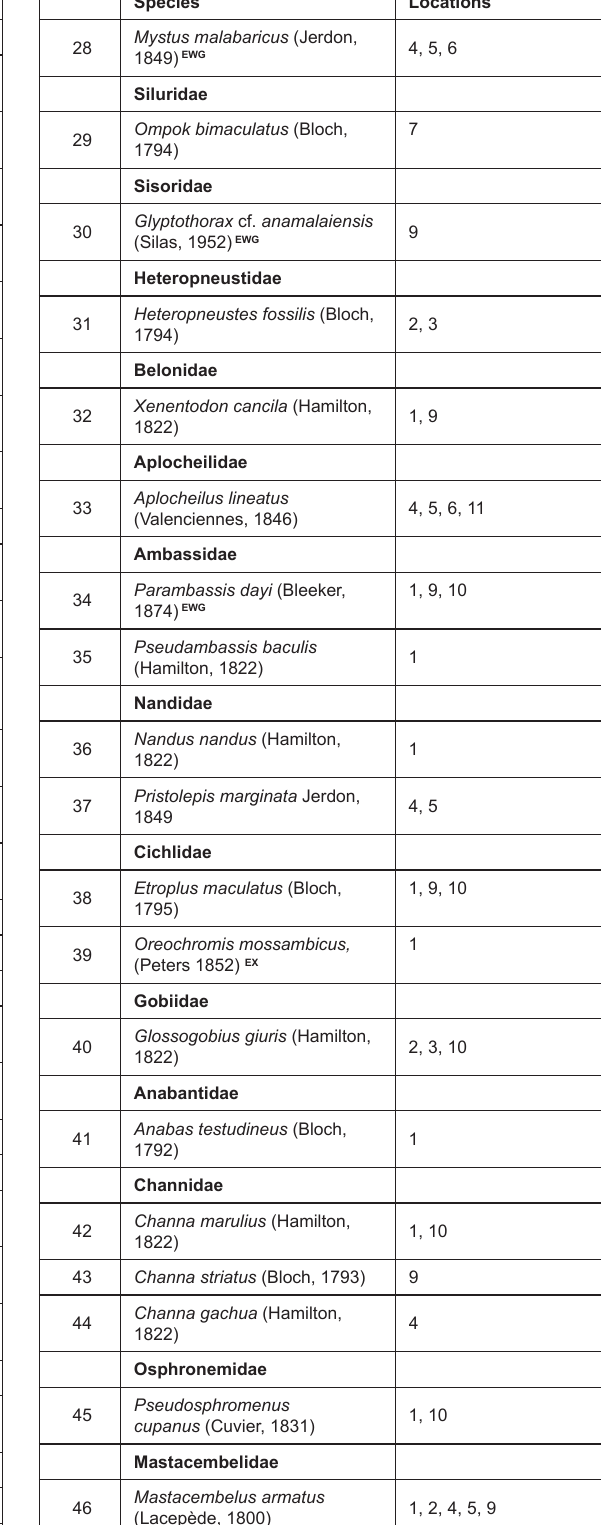
Table 2. List of species and their micro level distribution in Achankovil Forests